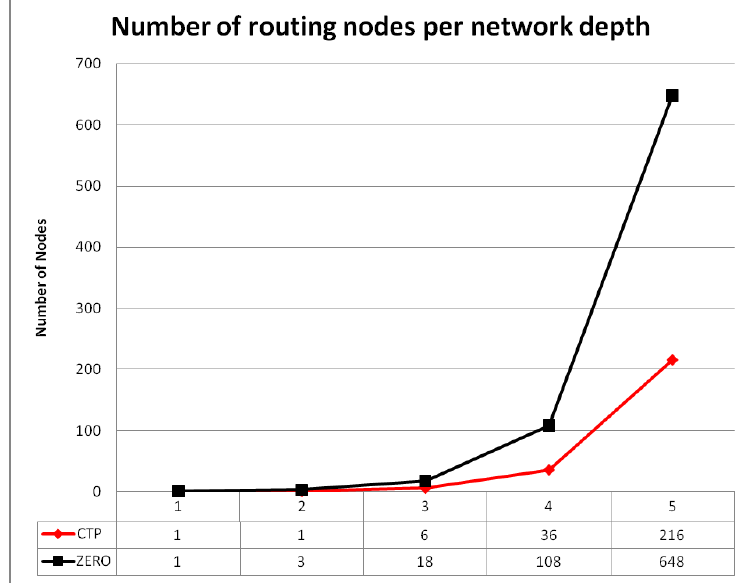
Figure 5. Average number of messages per relay (in average for the 50 repetitions of the experiment).